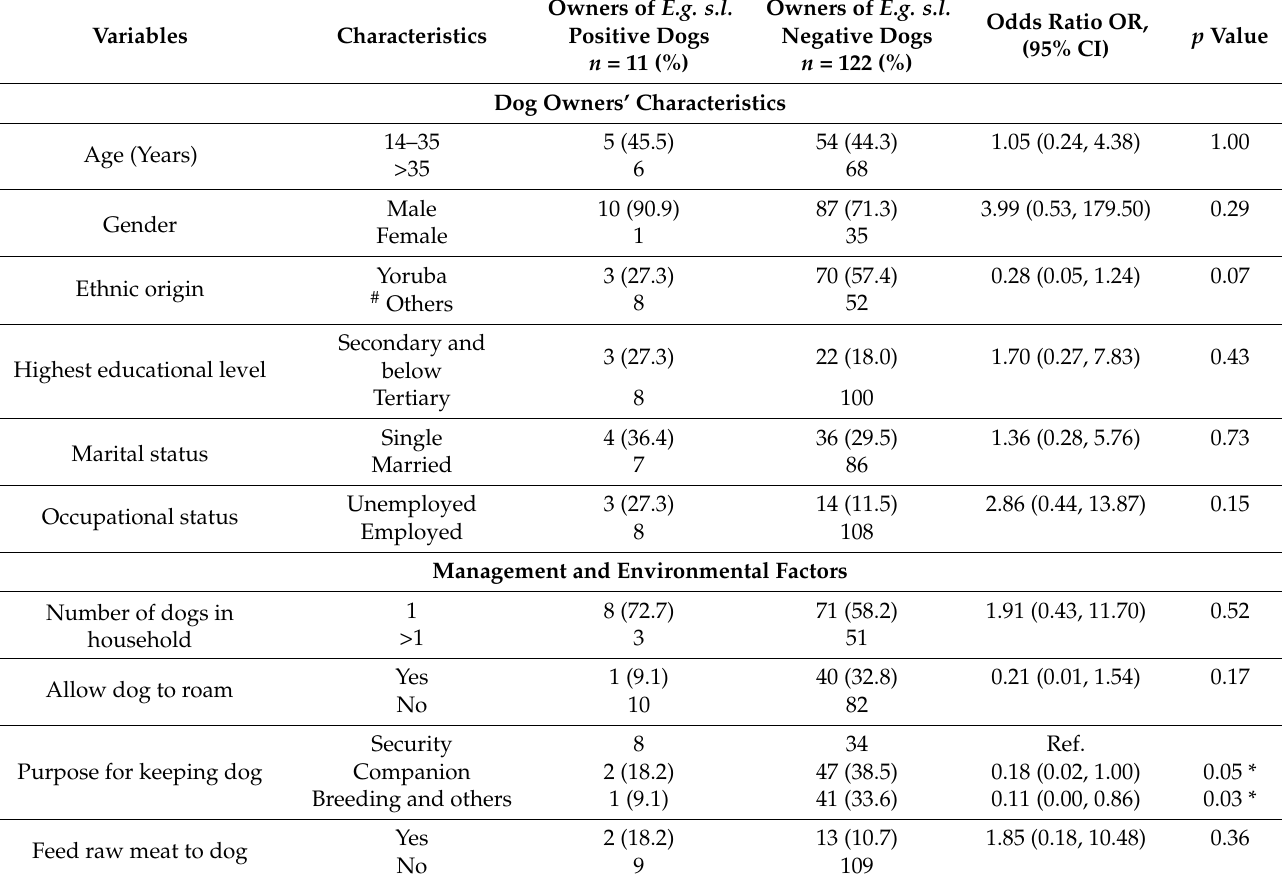
Table 4. Extrinsic factors associated with owning Echinococcus granulosus s.l. ( E.g. s.l. ) infected dogs in Lagos State, Southwest Nigeria, 2019 ( n =